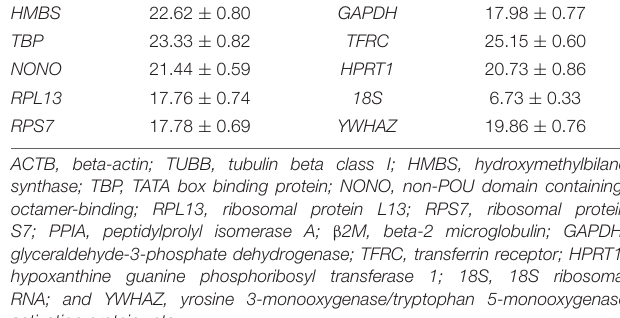
TABLE 4 | The average Ct values of the 14 reference genes in chicken primary preadipocytes and mature adipocytes. Gene The average Ct values The average Ct values